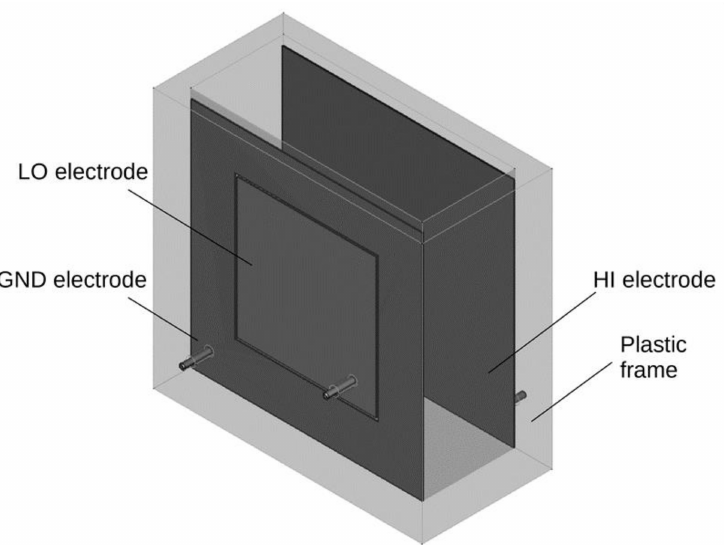
Figure 1. Depiction of the electrodes in the measuring box. HI electrode (high electric potential) sizes are 250 × 250 mm and LO electrode (low electric potential) sizes are 150 × 150 mm. The gap between GND electrode (grounded) and LO electrode is 2.5 mm. The electrodes are connected to terminals of an LCR bridge. The voltage between the terminals is 1 V (peak to peak).